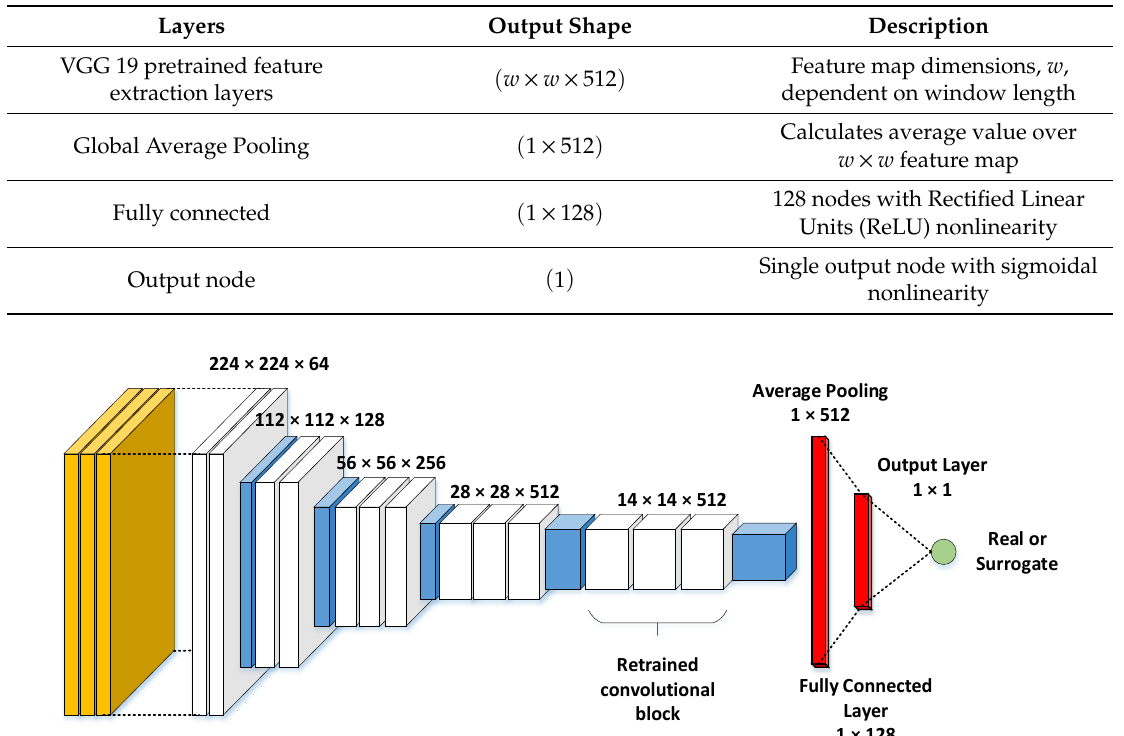
Table 1. Modified CNN architecture for contrast-based learning (Method II).